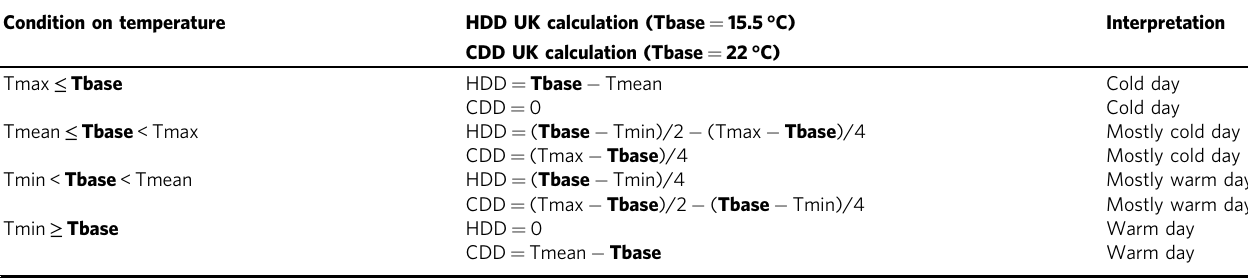
HDD is calculated with a base temperature (Tbase) of 15.5°C, and CDD with a base temperature of